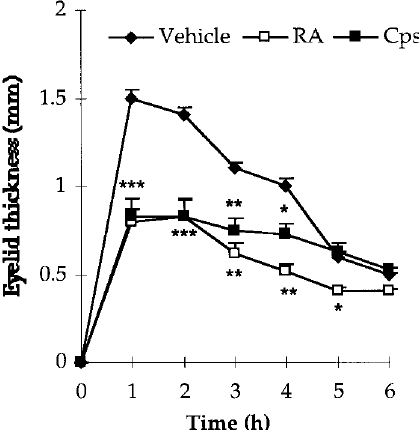
FIG. 4. Histamine-induced oedema of guinea-pig eyelid. Effect of 8-day treatment with ricinoleic acid (RA, 0.9mg/ guinea-pig) or capsaicin (Cps, 0.09mg/guinea-pig). Data are mean ± standard error (SE). n = 5–8 for each group. * p < 0.05; ** p < 0.01; *** p < 0.001 versus vehicle